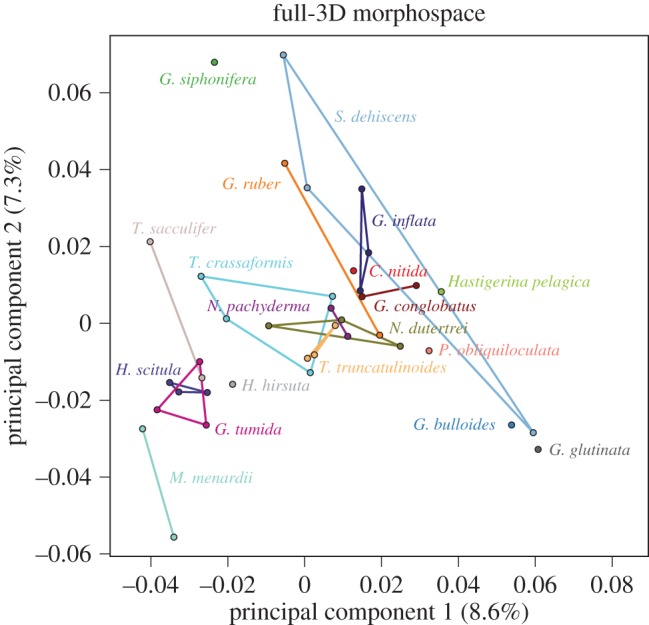
Morphospace (PC1 versus PC2) generated from the 39 specimens that comprise the Tohoku University dataset, aligned using the Boyer et al. automatic 3D geometric morphometrics algorithm [91] and sliding semi-landmarks. Coloured lines define convex hulls for each species (for species that include only two individuals, this is manifested as a single connecting line). H. pelagica, Hastigerina pelagica; H. scitula, Hirsutella scitula; G. bulloides, Globigerina bulloides; G. glutinata, Globigerinita glutinata.